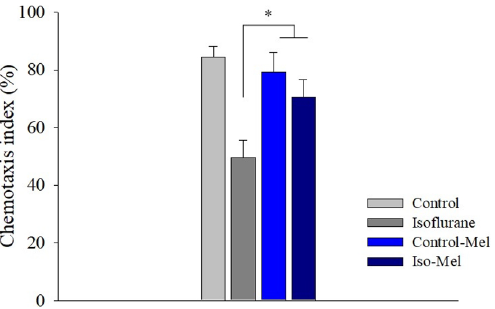
Figure 4. The chemotaxis index following the melatonin treatment. When C. elegans was not treated with melatonin, the chemotaxis index decreased significantly following isoflurane exposure. Melatonin treatment during the isoflurane exposure period could restore the chemotaxis index. *P <